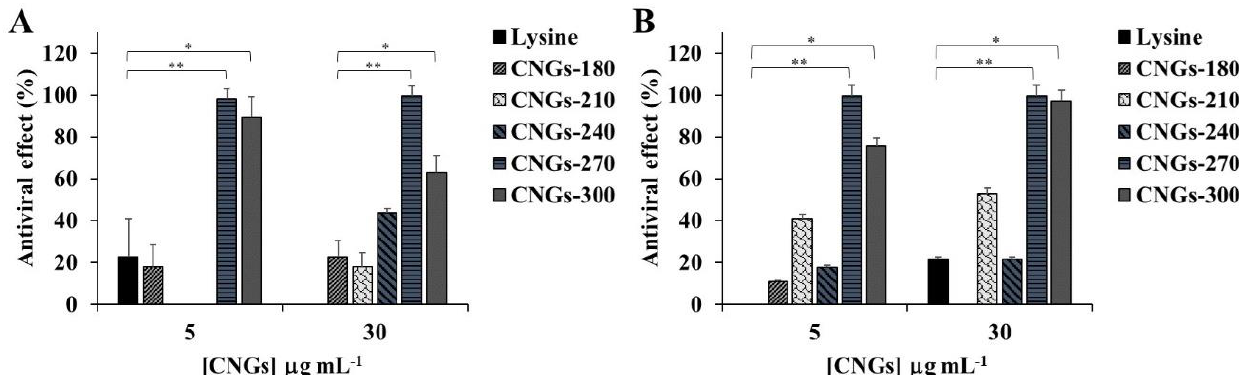
Figure 2. Inhibitory effects of lysine hydrochloride or CNGs on ( A ) BEFV-infected BHK-21 cells and ( B ) PRV-infected Vero cells. The viruses and CNG mixtures were inoculated into BHK-21 or Vero cells for infection. After 30 min at 37 °C incubation, the inoculum was replaced with growth media and incubated for 72 h before the calculation of antiviral effects. The error bars represent standard deviations for three independent experiments. The results were analyzed using ANOVA multiple comparisons (* p < 0.05, ** p < 0.01). Table 1. CEID 50 mL –1 and antiviral effect (%) of CNGs against IBV infection in the chicken embryo.